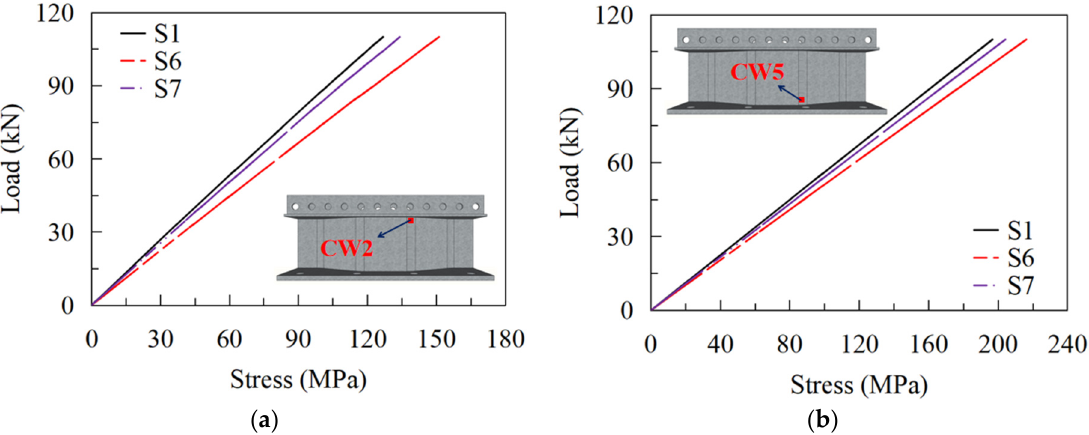
Figure 24. Load-stress curves for models with different corrugations of the web: ( a ) CW2; ( b ) CW5.